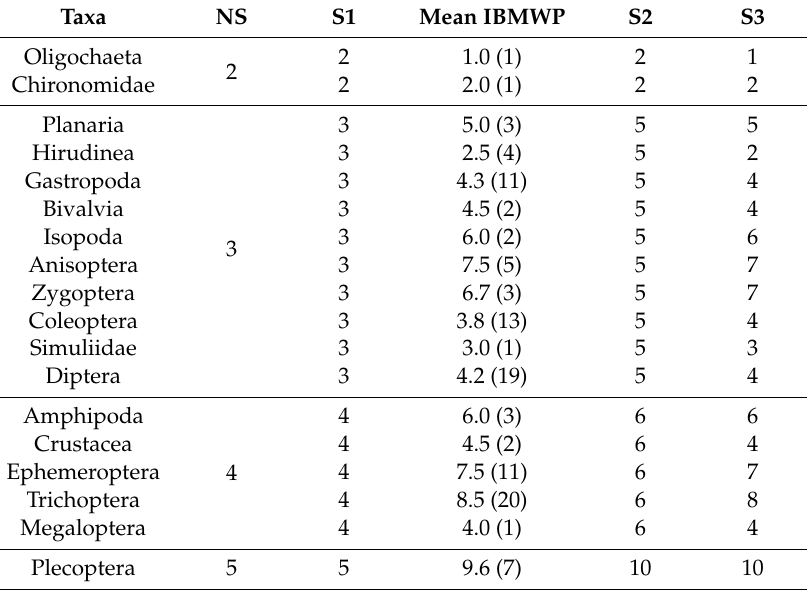
Table 1. Tolerance scores established for surrogates for the di ff erent tested metrics. The nonsummative (NS) metric score corresponds to the highest surrogate score. Scores of the other metrics (S1, S2, S3) are obtained by the sum of the scores of all the surrogates present. The Mean IBMWP column shows the mean tolerance score attributed by IBMWP (Iberian Biological Monitoring Working Party) to families included in the surrogate. The number of families included in each mean are shown in parentheses.